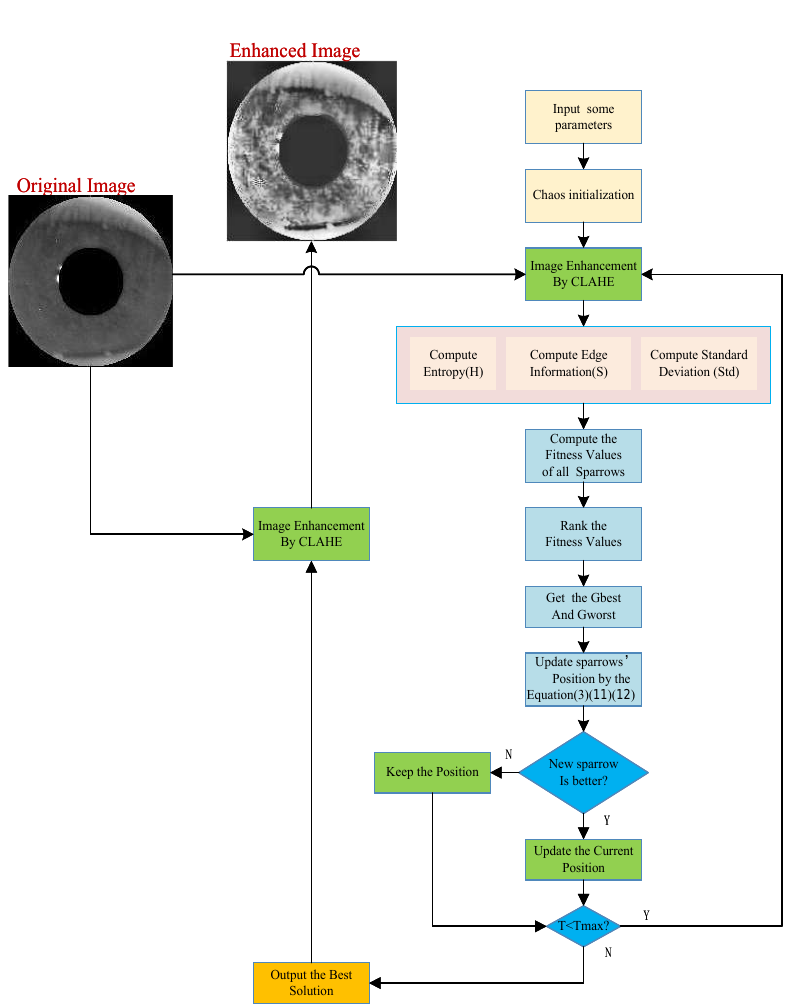
Figure 3. The flowchart of